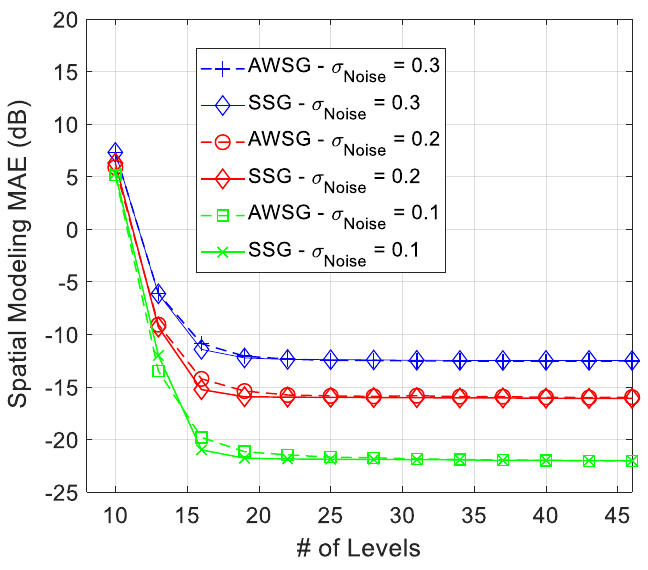
Figure 5. Comparison between the convergence speed of AWSG and SSG, during convergence process of the algorithm.